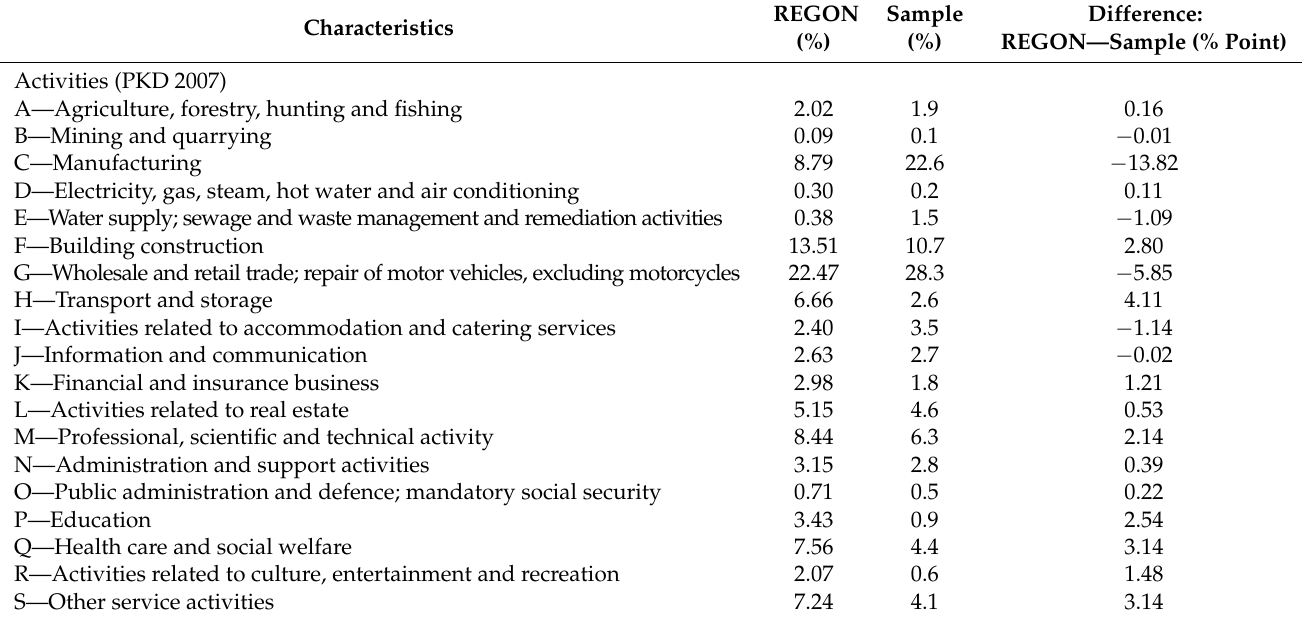
Table 3. Structure of the sample.